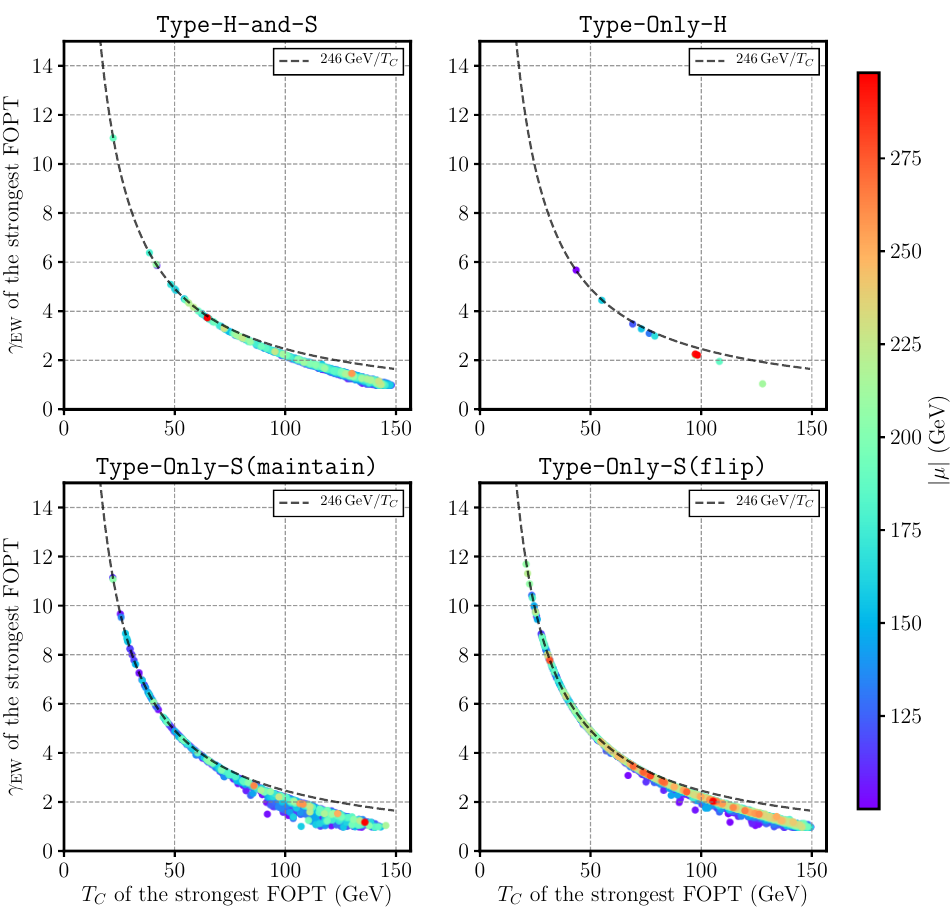
Figure 3 . The critical temperature and order parameter for the strongest PTs for samples for which the strongest FOPT ends in the SM vacuum. The points are colored by the e(cid:11)ective (cid:22) -parameter. positive or negative, because the input v S includes both signs. We have checked that the singlet VEV at the true vacuum has the same sign as the input v S